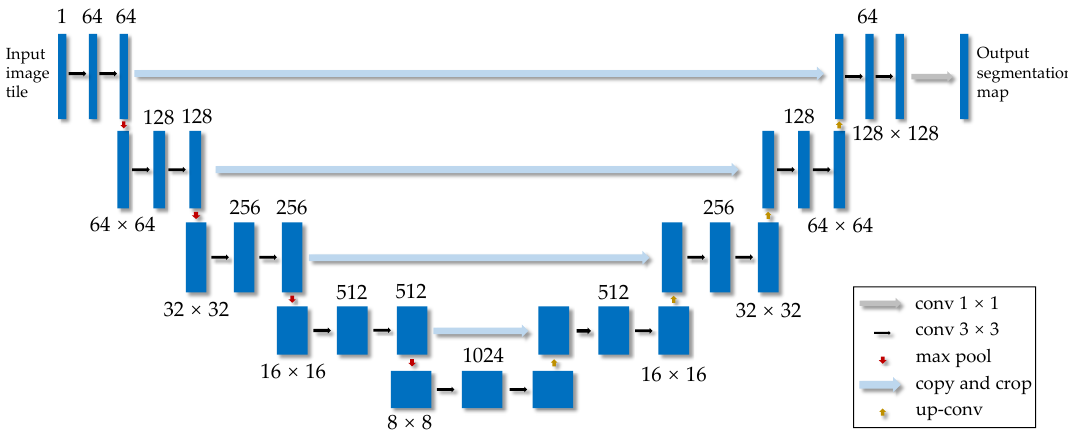
Figure 4. Structure diagram of the U-Net model used in this study.